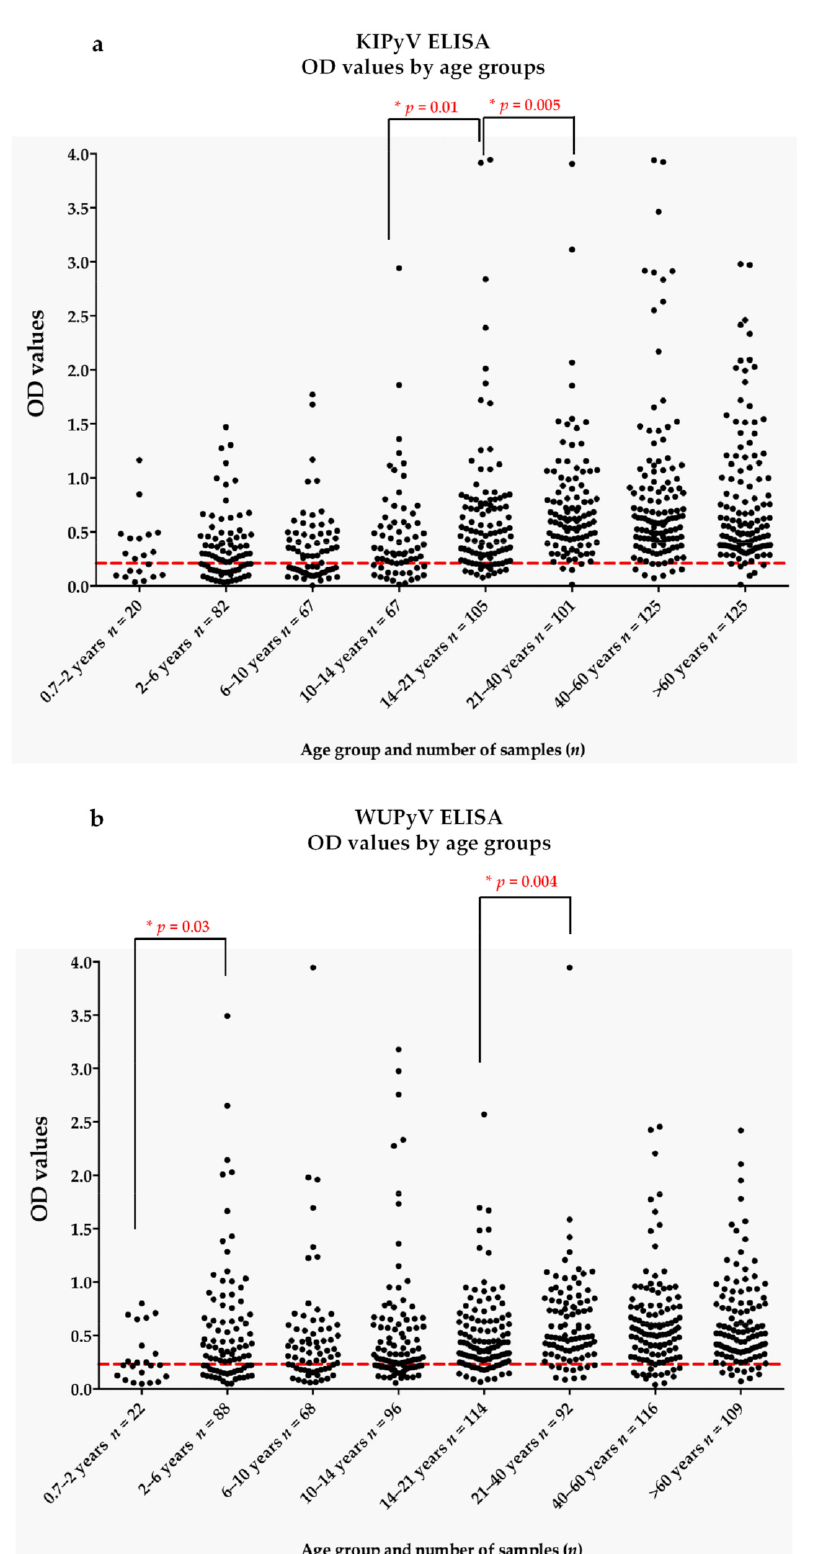
Figure 3. Age distribution of optical density (OD) values measured in the KI polyomavirus (KIPyV) ( a ) and WU polyomavirus (WUPyV). ( b ) enzyme-linked immunosorbent assay (ELISA). The red dashed line represents the cut-off value above which the seropositivity